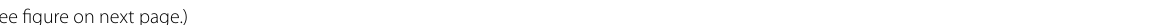
arrow)(See figure on next Fig. 7 A 54‑year‑old female employee, obese (BMI 39.6 kg/m 2 ), presented with a sudden onset of posteromedial right knee pain with a popping = sound after a twisting injury. The patient had difficulty climbing the stairs and squatting for one week (acute or early period). By the comparison between the pre‑ and post‑varus stress medial meniscus extrusion amount (MME). Without varus stress position ( a and c ), the coronal PD‑SPAIR WI of the right knee shows a negative extruded medial meniscus of approximately 2.5 mm from the medial margin of the tibial plateau to the outer border of the extruded meniscus (orange arrow). With varus stress position ( b and d ), the MME changed from negative to positive extrusion of approximately 4.5 mm (white